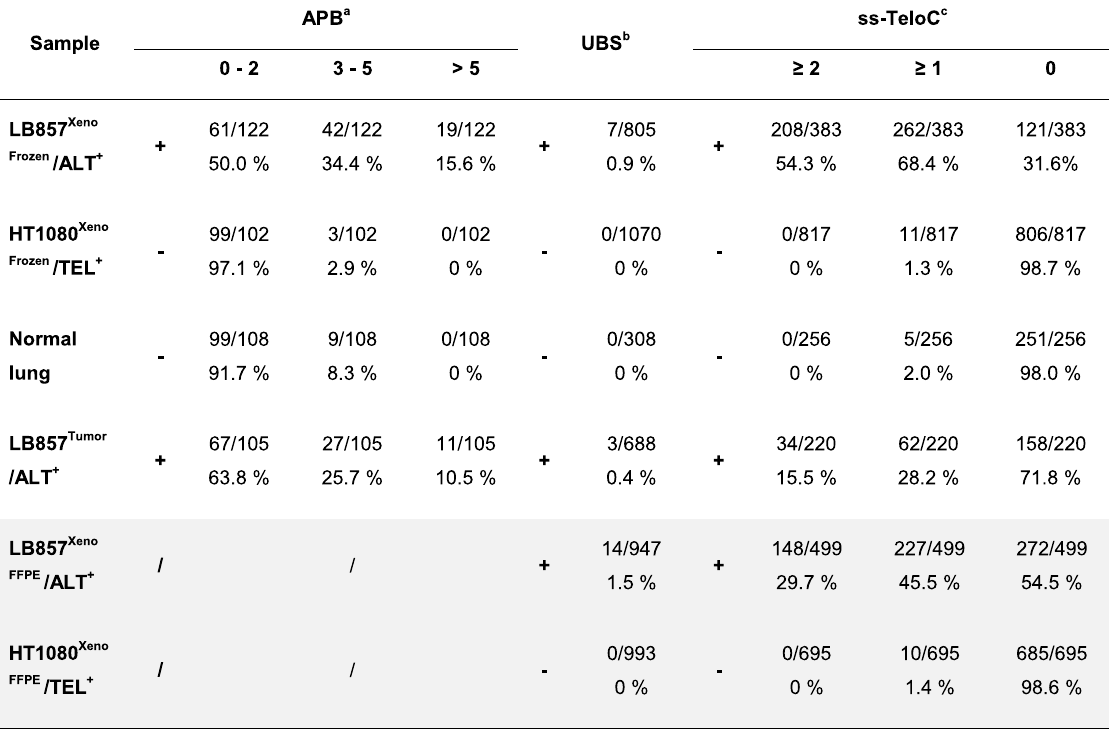
Table 1 APBs, UBS and ss-TeloC detection in xenografts, normal human lung and an ALT